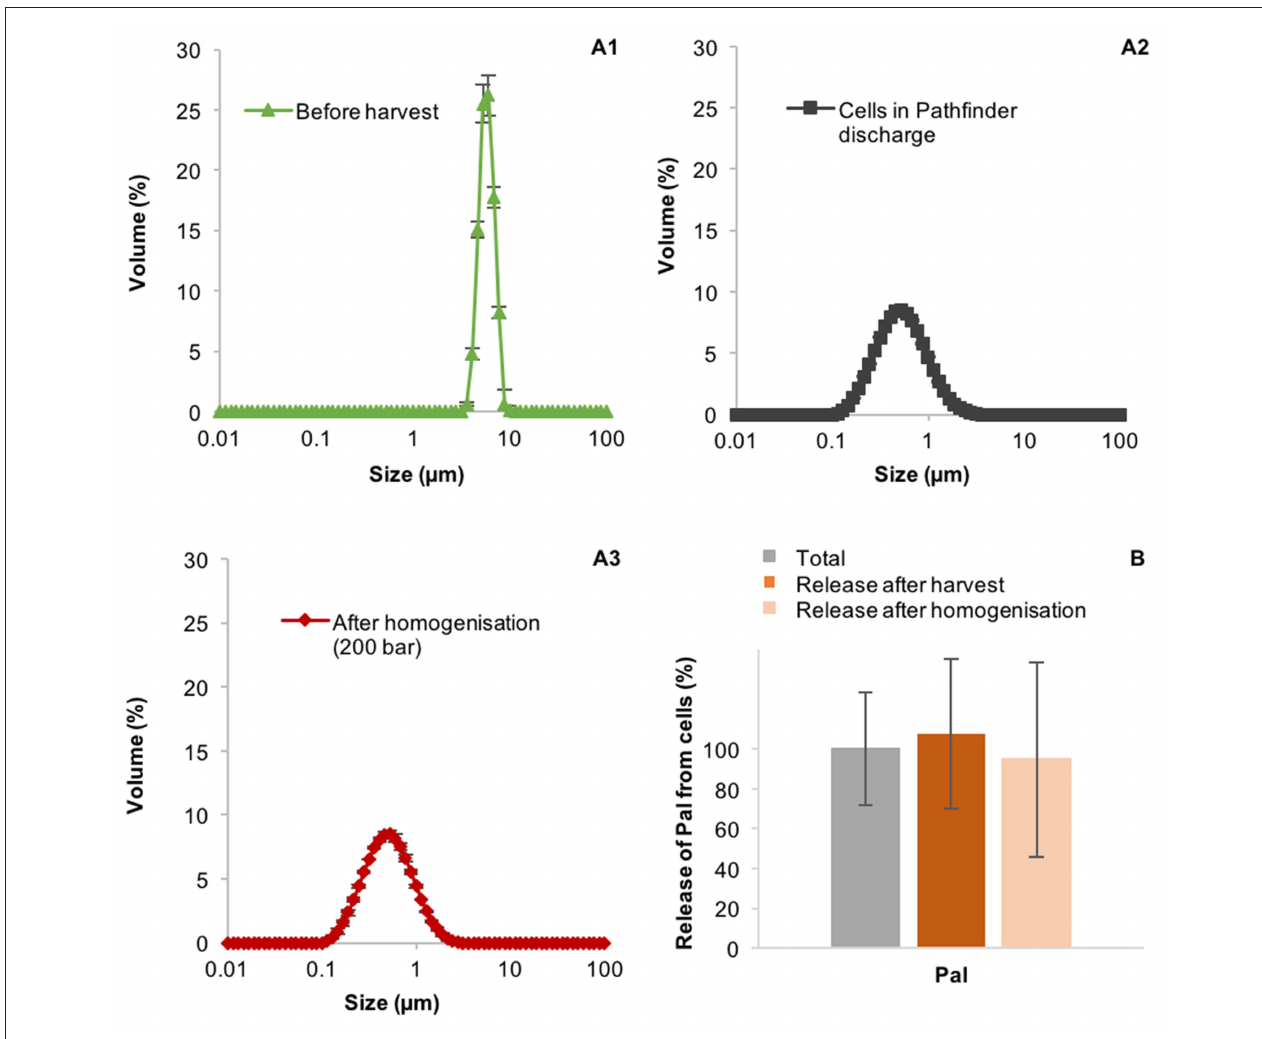
FIGURE 7 | Integrity of Chlamydomonas reinhardtii TN72 cells (A1–3) and product release (B) during harvest with a GEA Westfalia Pathfinder PSC-1 and subsequent homogenization. A 100L pilot-scale culture was harvested at a flow rate of 120 L · h − 1 (Q/ 95 × 10 − 9 m · s − 1 ). Subsequently, the cells were treated with a SPX 1000 homogenizer. The cell integrity was determined by particle size measurements and the amount of the product Pal by western blot analyses. Error bars represent ± 1 SD ( n ≥